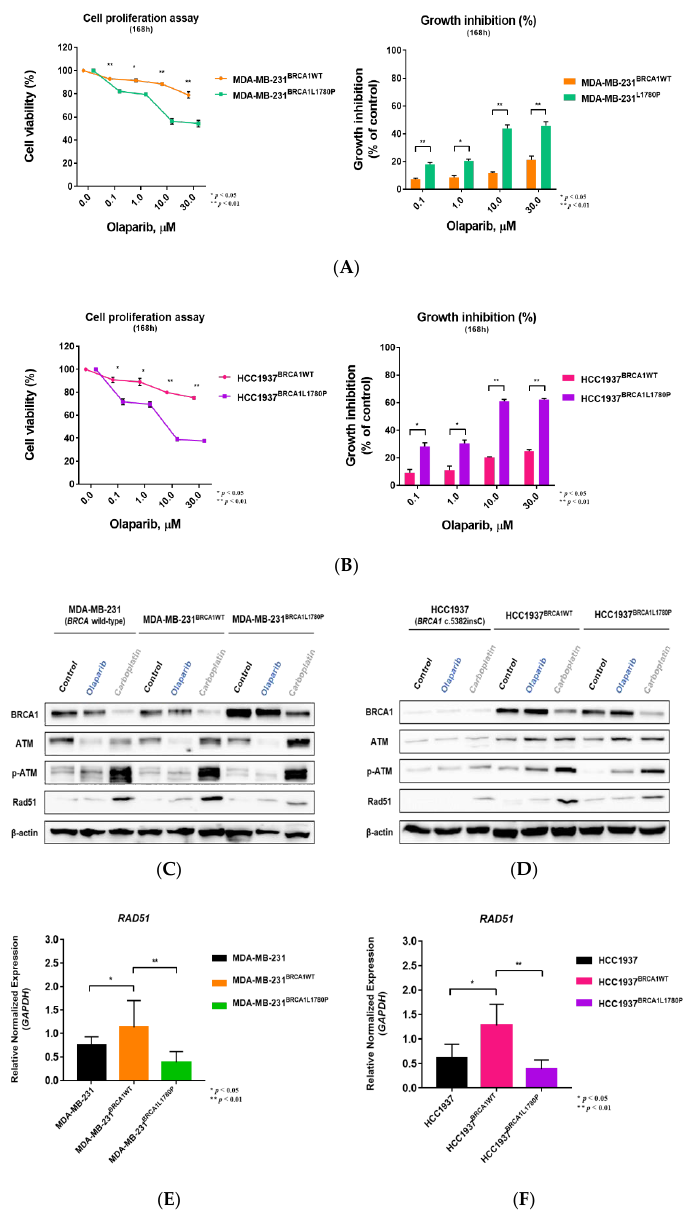
Figure 4. Olaparib sensitivity in stable cell lines stably expressing BRCA1. ( A , B ) Cell viability and growth inhibition following olaparib treatment in BRCA1-expressing cell lines. ( C , D ) BRCA1 L1780P mutant cells showed downregulation of RAD51 expression following carboplatin treat- ment. ( E , F ) RAD51 mRNA expression in BRCA1 L1780P mutant cells was downregulated following carboplatin treatment. Cells stably expressing BRCA1 wild-type and L1780P mutant were used. ( A , C , E ) MDA-MB-231 and ( B , D , F ) HCC1937 cells. Data are reported as the mean ± standard devia- tion (SD). Statistical analysis was performed using the chi-square test. (* p < 0.05, ** p <